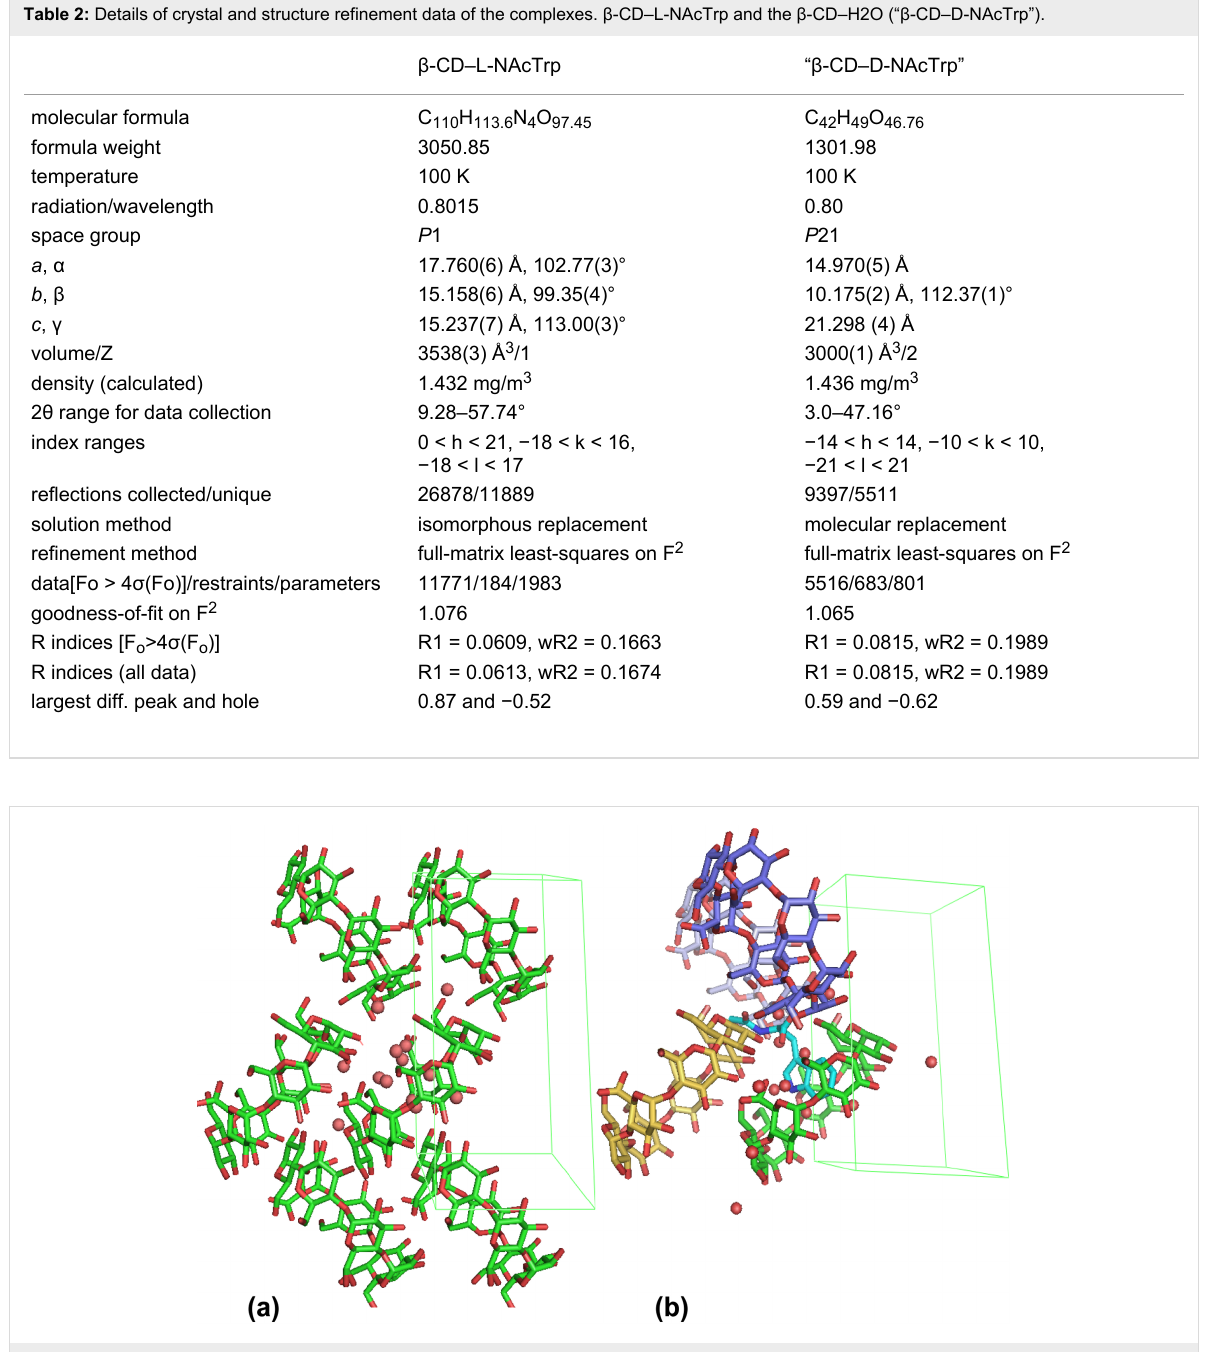
ture as an isomorph. It can be seen (after the appropriate trans- formation of coordinates due to different origin and axes; Sup- porting Information File 1, Figures S4 and S5) that the hydrated β -CD macrocycle does not superpose exactly in the lattice of “ β -CD–D-NAcTrp”, which may render the two structures not quite isomorphous. It is worth noting that many of the